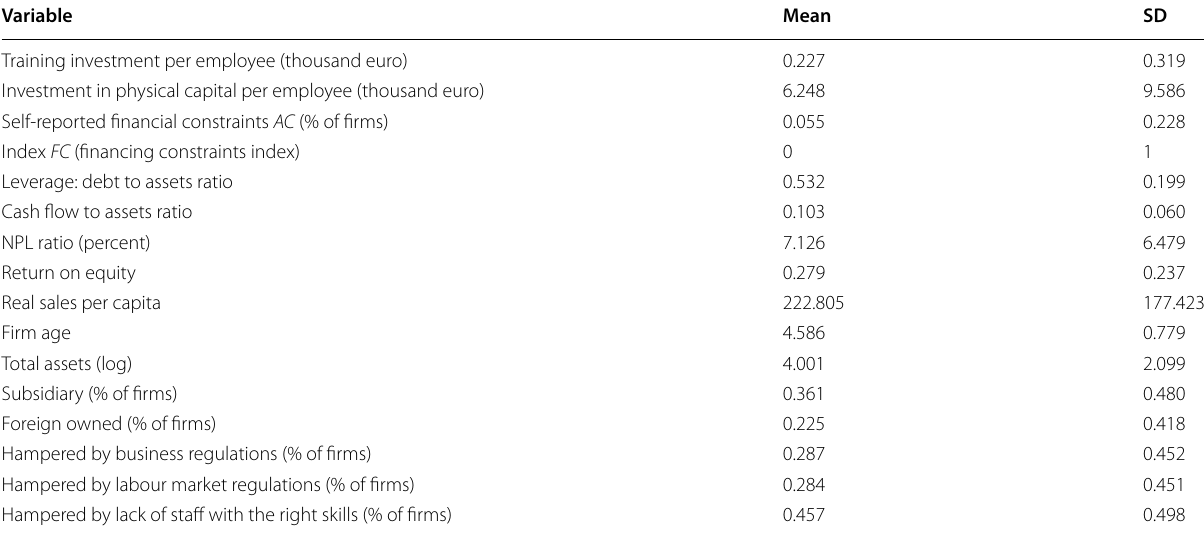
Weighted means using EIBIS value added weights. Firm age: 1: less than 2 years; 2: 2 to 5 years; 3: 5 to 10 years; 4: 10 to 20 years; 5: more than 20